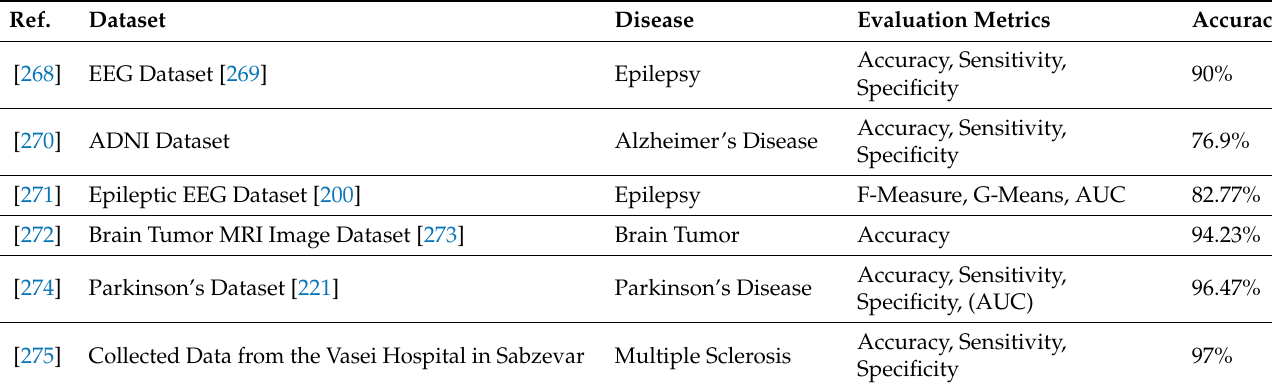
Table 17. ELM classifier result analysis on various